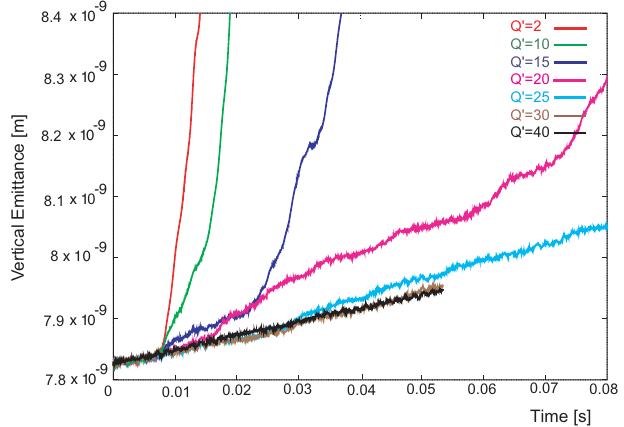
FIG. 10. (Color) Vertical emittance growth for different chro- (cid:2) 6 (cid:6) 10 11 m (cid:4) 3 maticities, at (cid:2) e